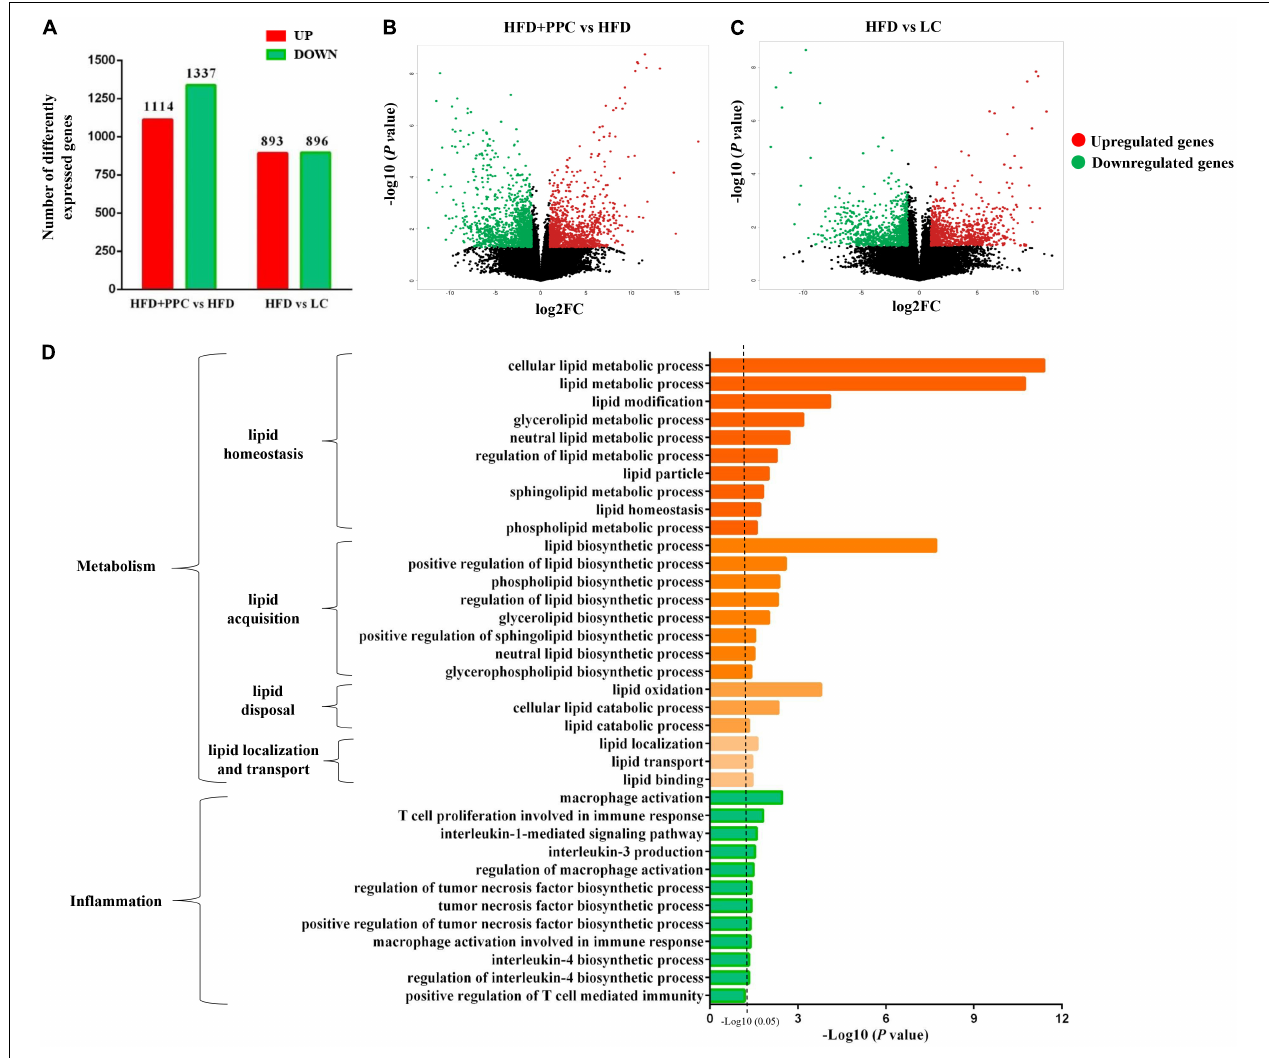
FIGURE 3 | PPC supplementation remodels the transcriptome profile of liver in the mice fed by HFD. (A) The number of DEGs. (B) The volcano plot shows the distributions of DEGs between HFD + PPC and HFD mice. (C) The volcano plot of DEGs between HFD and LC. The x -axis indicates the fold change. red dots, upregulated; green dots, downregulated. (D) Go annotation of DEGs between HFD + PPC and HFD with terms related to hepatic metabolism and inflammation. n = 3 for each group.